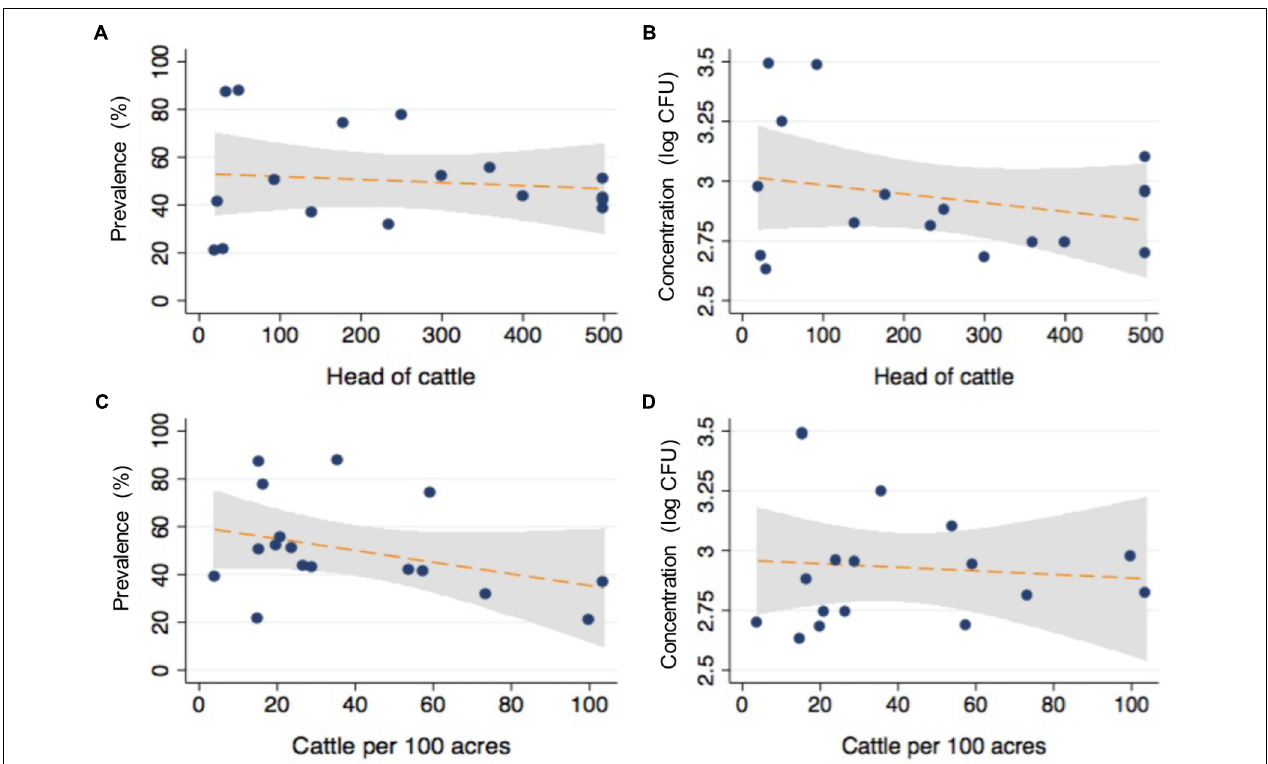
FIGURE 3 | Relationship between cattle density and CRB isolated from commercial beef farms. The relationship between total number of cattle (A,B) and the density (C,D) of cattle per 100 acres with the prevalence and concentration of CRB from fecal samples are presented as scatter plots from values corresponding to individual farms (blue dots), with the corresponding fits from linear regression models with 95% confidence intervals for the slope (orange line, gray shaded